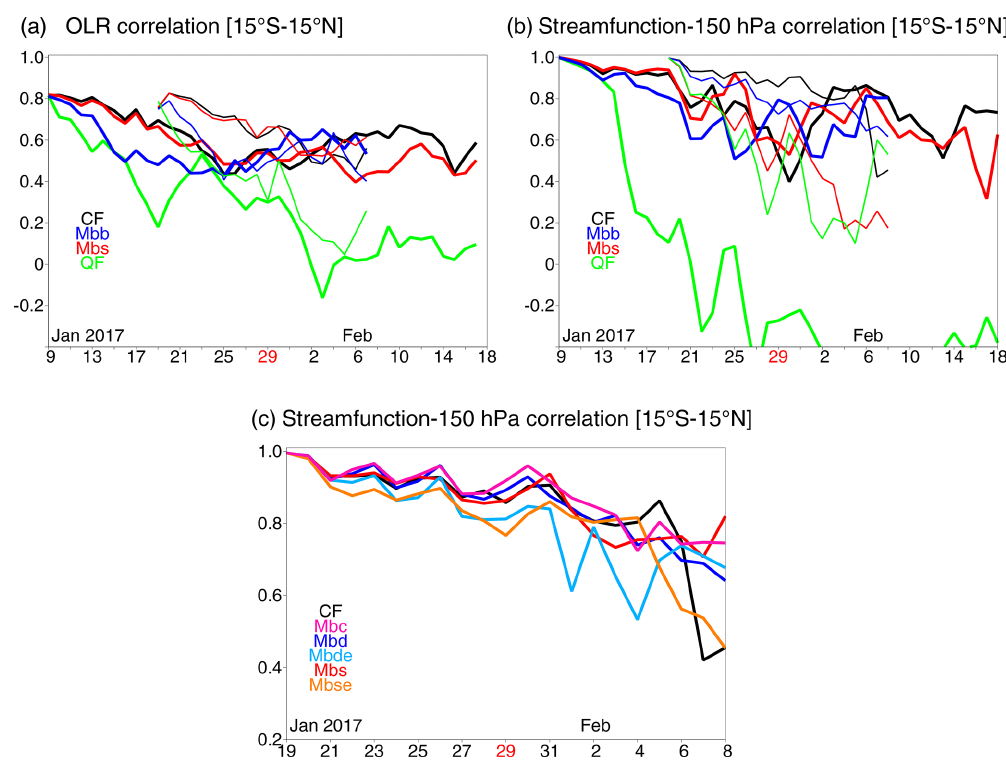
Figure 6. Time series of pattern correlations between the forecasts and the analysis over the longitudinal bands between 15 ◦ S and 15 ◦ N for (a) OLR and (b, c) the 150hPa level stream function. The cases shown in panels (a) and (b) are CF (black), Mbb (blue), Mbs (red) and QF (green); the cases shown in panel (c) are CF (black), Mbc (pink), Mbs (red), Mbd (blue), Mbde (light blue) and Mbse (orange). The standard 20d and the 40d extended forecasts are shown by thin and thick curves